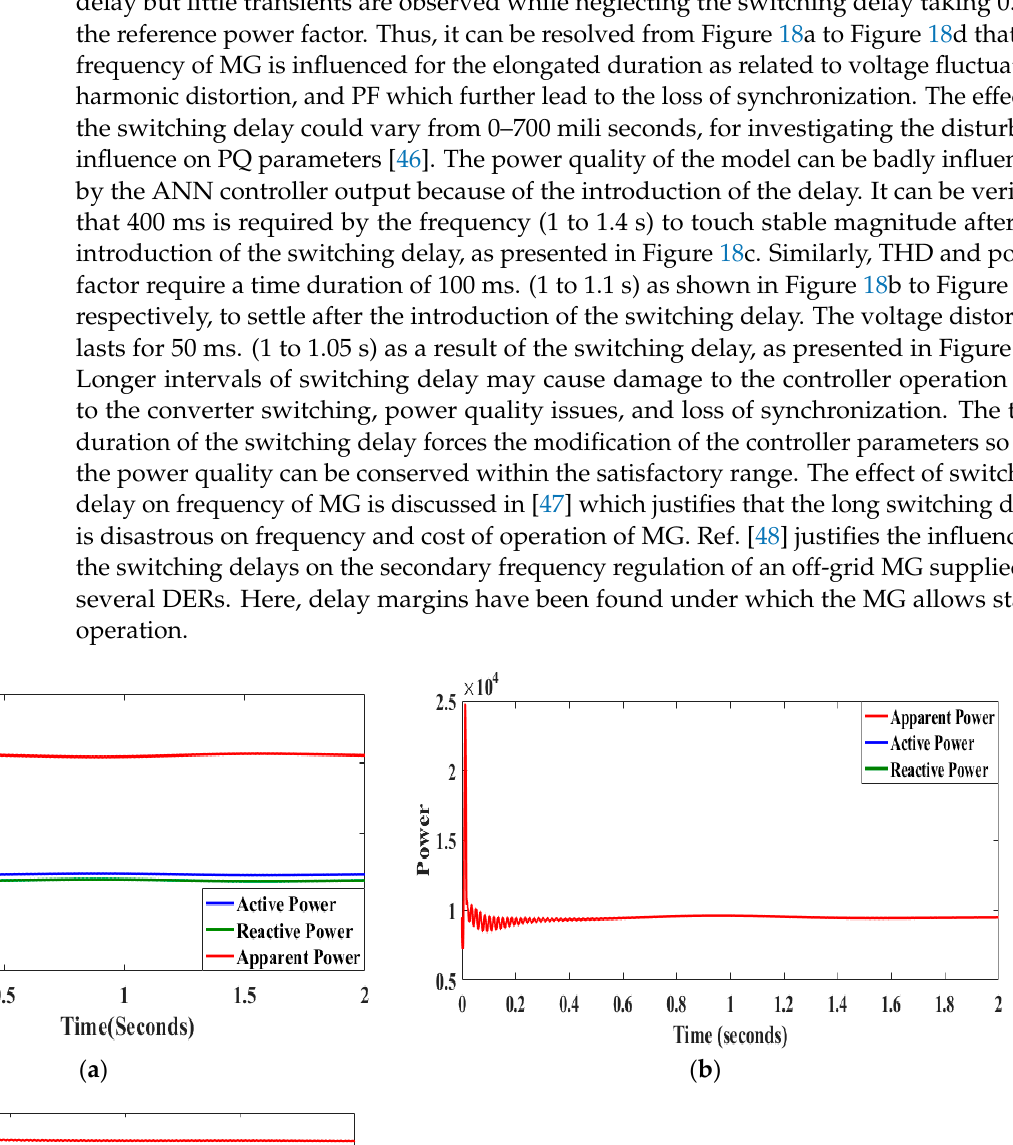
Figure 16. ( a ). Voltage deviation with/without influence of LI. ( b ) THD with/without influence of LI. ( c ) Frequency with/without influence of LI. ( d ) Power Factor with/without influence of LI.